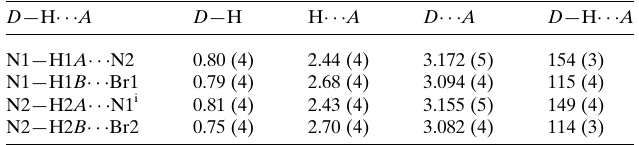
Table 1 Hydrogen-bond geometry (A˚ , (cid:3) ) for 1 .